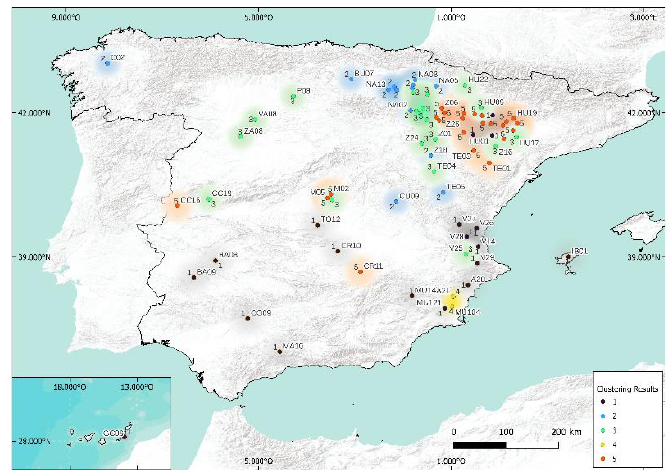
Figure 12. Using k-means for 5 clusters.